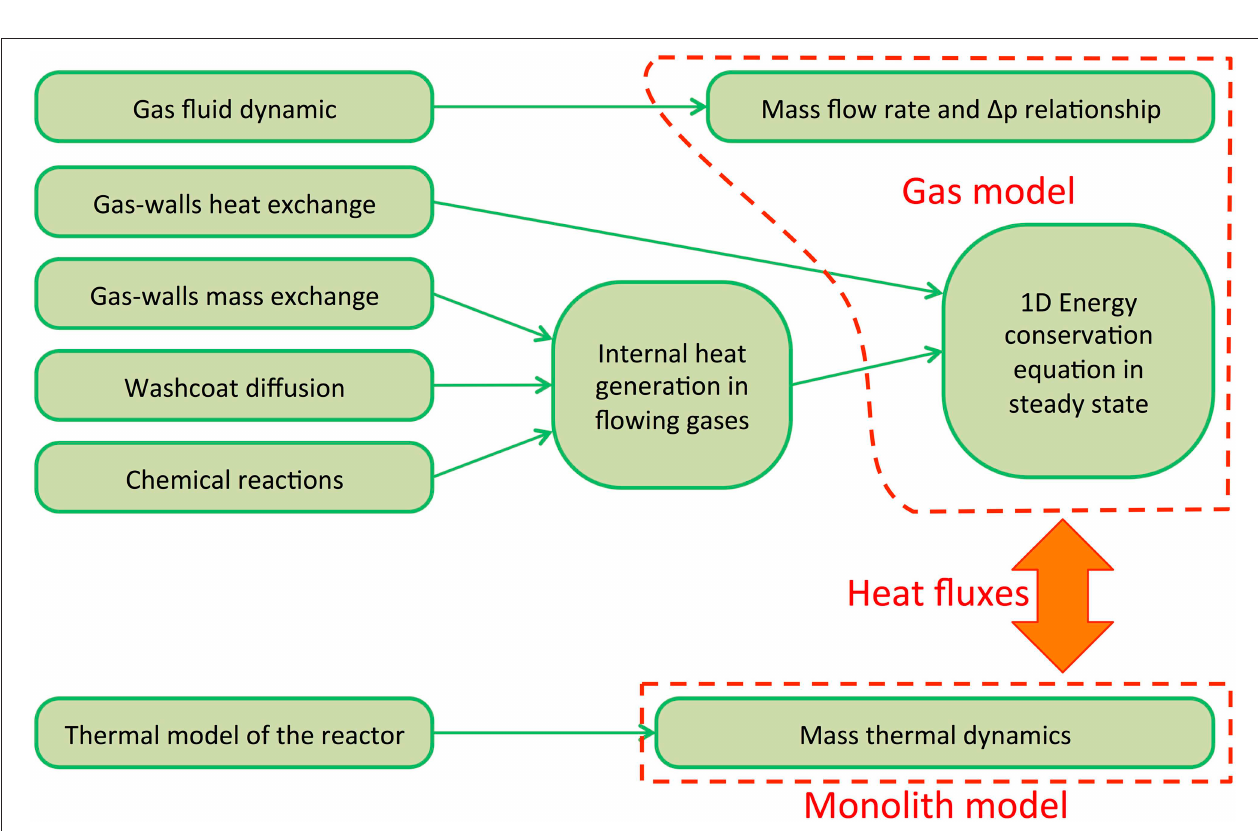
FIGURE 3 | Layout of the model of the catalyst